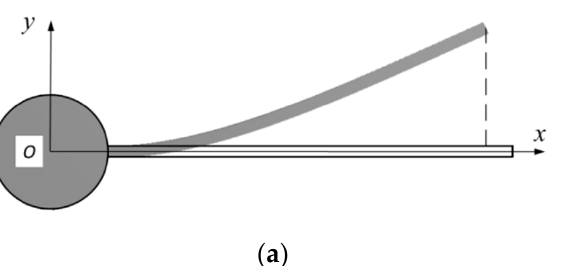
Figure 3. Illustration of two coordinate systems: ( a ) tangential Coordinate System; ( b ) virtual Link Coordinate System.